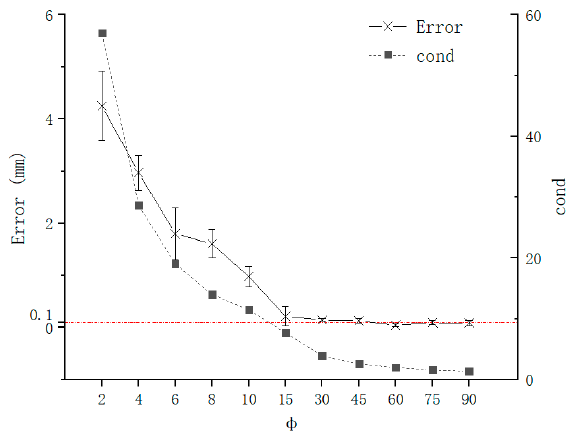
Figure 12. Error of TCPP with φ .